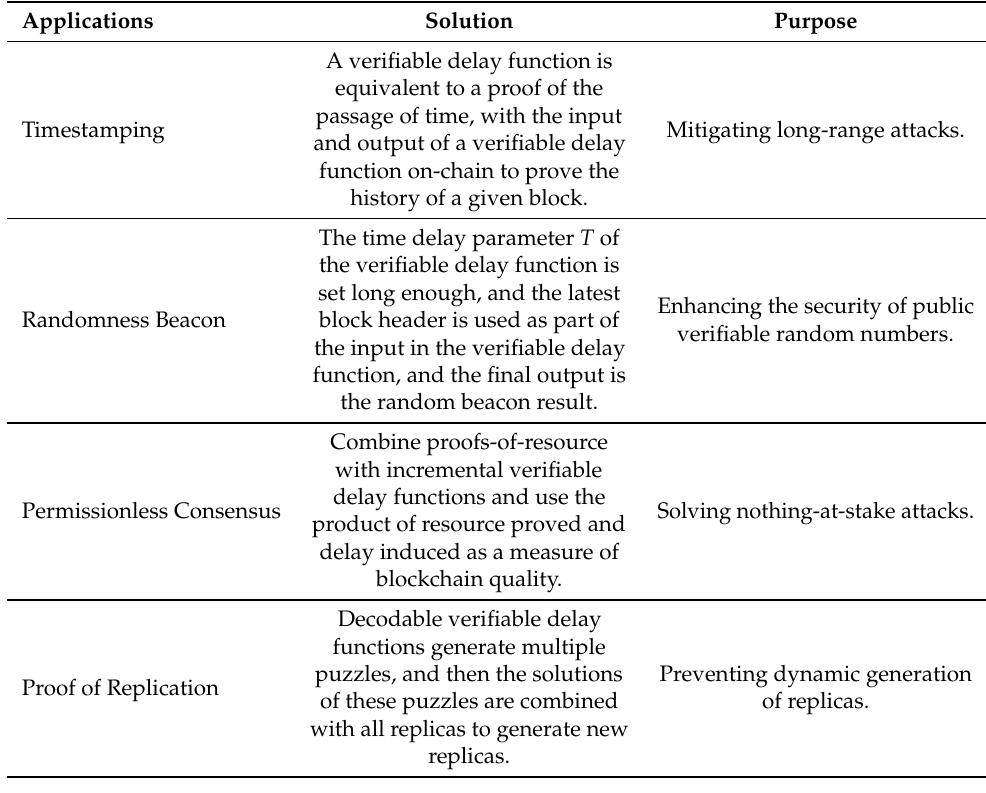
Table 3. Blockchain-related applications of verifiable delay